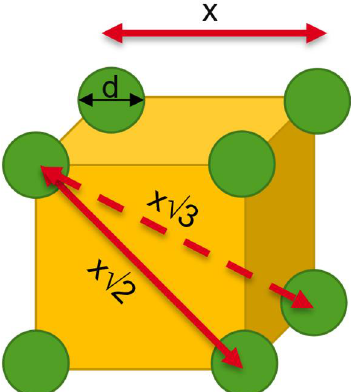
Figure 1. Model of a cubic grid to illustrate the distribution of particles inside a Nano-/Microcomposition. Green spheres = drug particles with diameter d, yellow = polymer matrix.